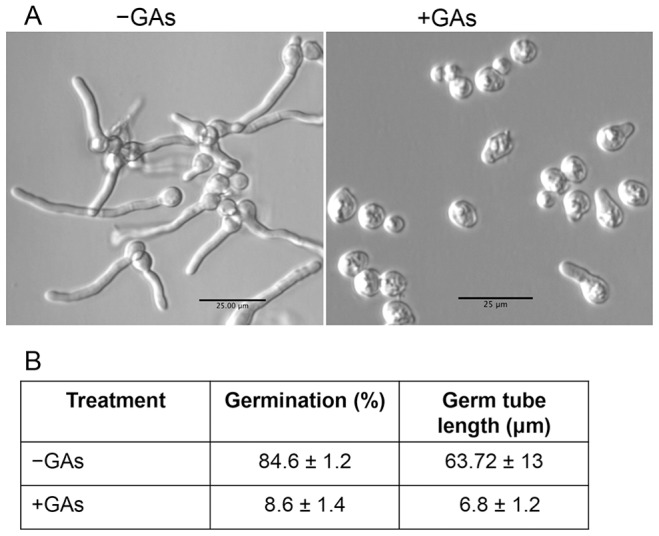
Effect of GAs on germination of Aspergillus fumigatus spores.(A) A conidiospore suspension was incubated in RPMI medium at 37°C with (40 µg/ml) or without GAs for 15 h under static condition in microtiter wells. Percentage of germination was calculated at least from nine different fields from triplicate wells. A spore is considered germinated when the length of the germ tube is twice or more the size of a spore. Scale bars = 25 µm. (B) Table showing the impact of GAs on A. fumigatus spore germination and germ tube lengths. The lengths of germ tubes were measured by using µScope software (µScope Essential) and shown ± SD.